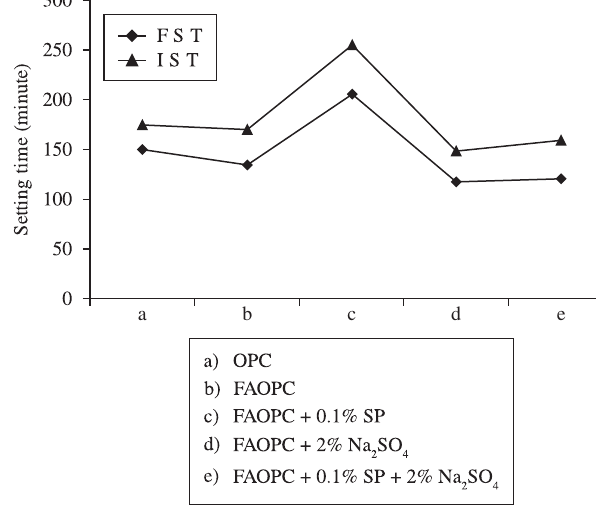
Figure 2. Variation of water consistency.